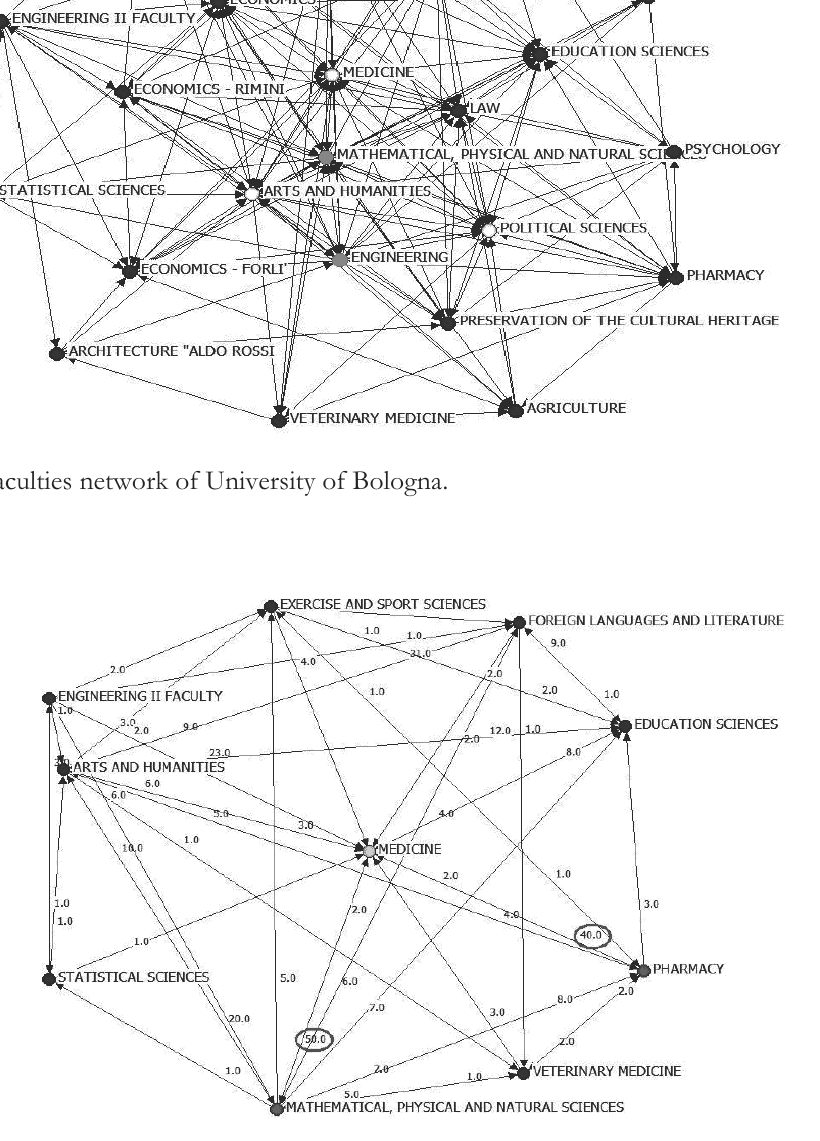
Figure 3 – Egonet of